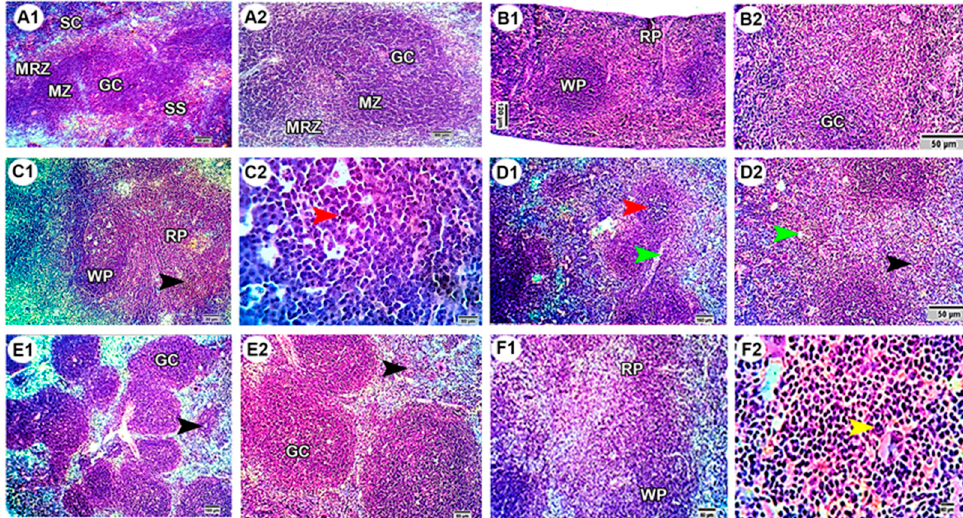
Figure 5. Photomicrographs of spleen sections stained with H&E. ( A ) control group, ( B ) quercetin- treated group, ( C ) MWCNTs low dose-treated group, ( D ) MWCNTs high dose-treated group, ( E ) MWCNTs low-dose and quercetin co-treated group, ( F ) MWCNTs high-dose and quercetin co- treated group. Arrowheads and labels were explained in the main text. Scale bars, 80 µm ( A1 , A2 ), 120 µ m ( B1 ), 50 µ m ( B2 ). Low ( A1 – F1 ) and high ( A2 – F2 ) magnification images were provided for each